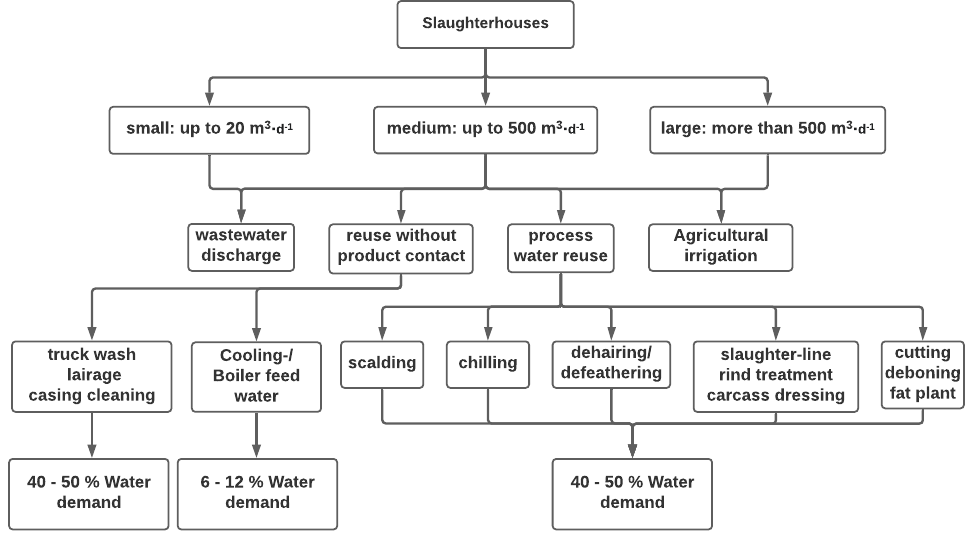
Figure 2. Overview wastewater reuse possibilities